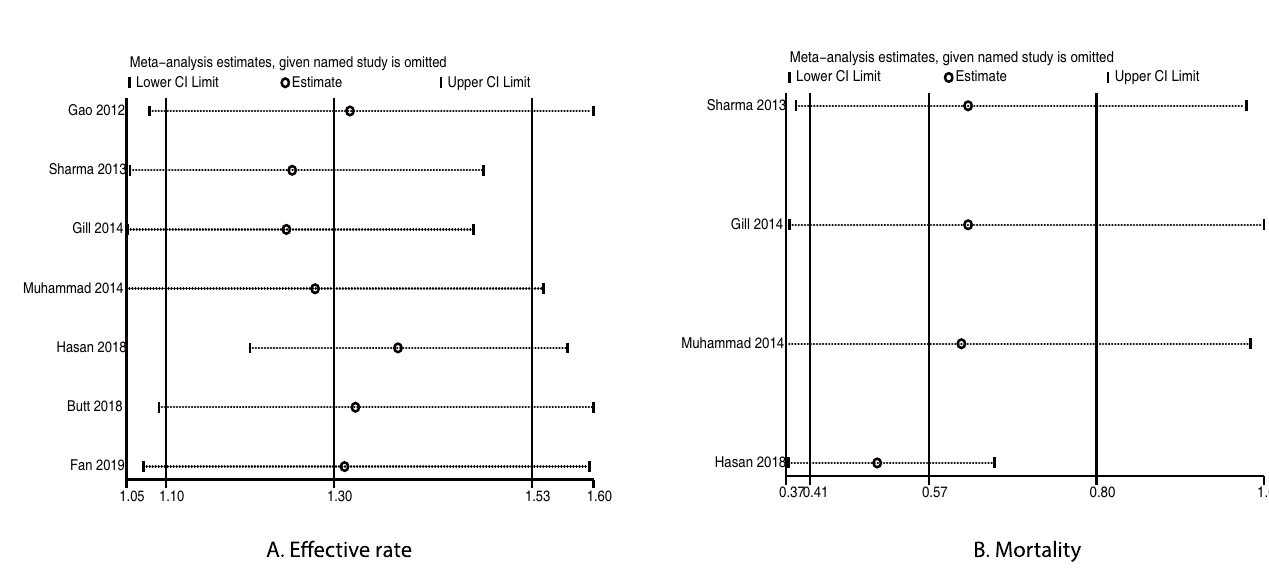
Fig 4. Sensitivity analyses for effective rate and